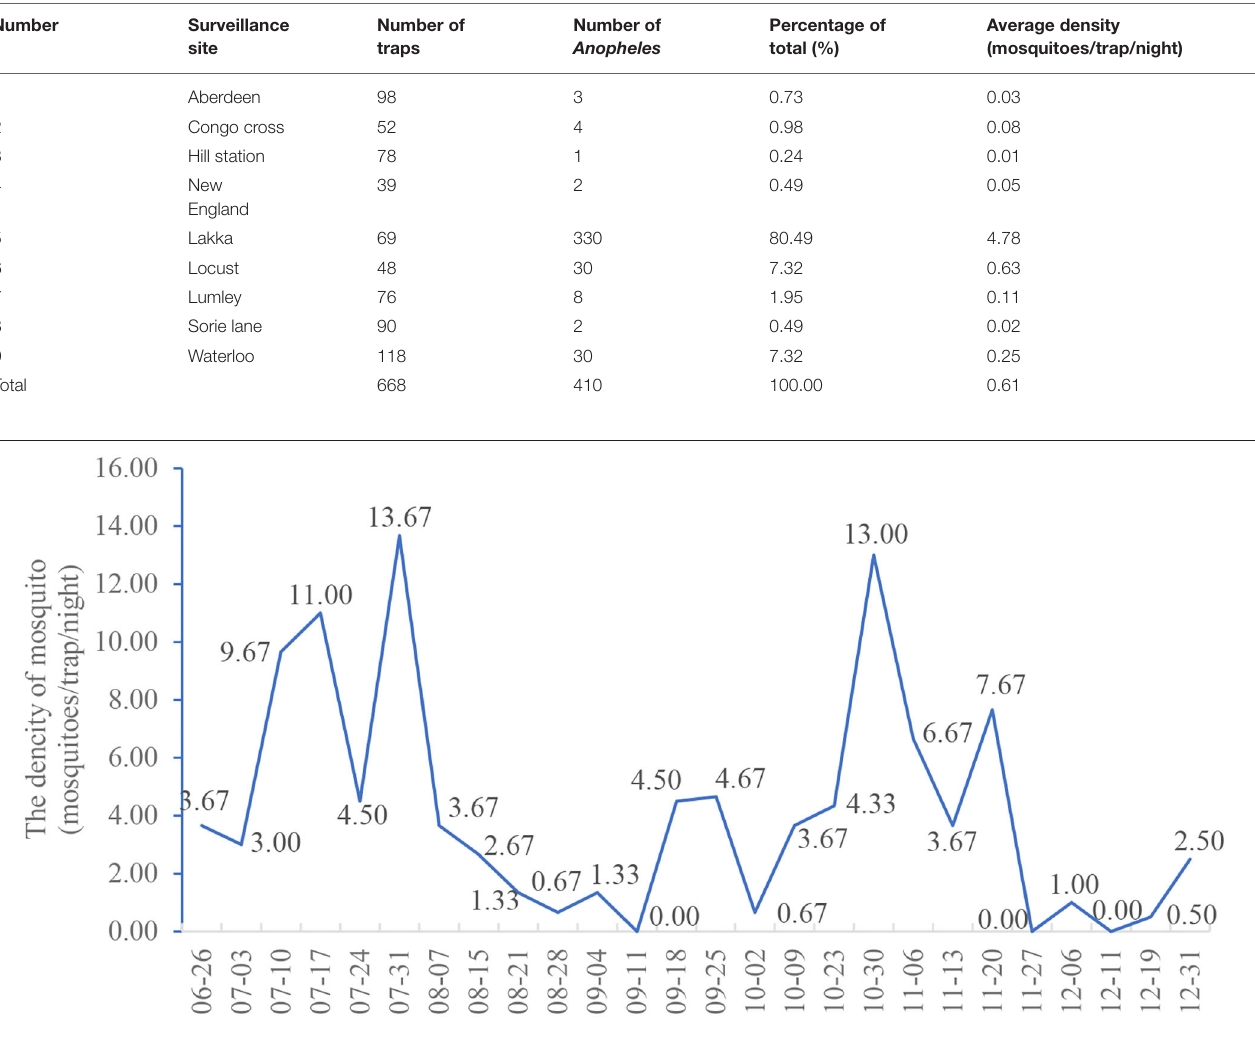
FIGURE 2 | Seasonal variation of the mean density of Anopheles in Lakka, Freetown from June to December 2019.